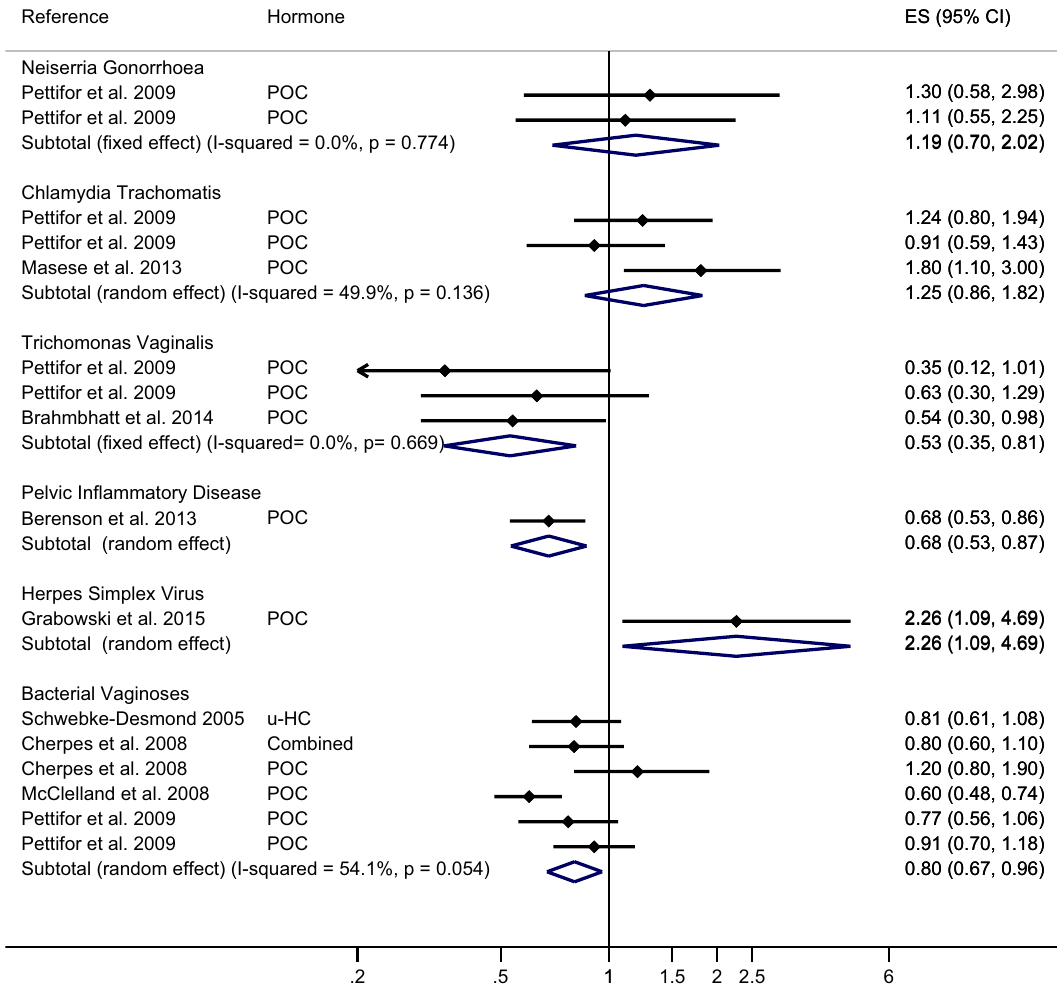
Figure 4. Meta-analysis of the association between hormonal contraceptives and the incidence of STIs/BV. The diamond in the middle of each horizontal line represents the point estimate of the effect for a single study. Each horizontal lines depict the 95% confidence interval (CI) for a study and the lines that extend beyond the specified value range are cropped and adorned with arrows. The group-specific effect size is plotted by diamond (without horizontal line) with the width corresponding to its 95%